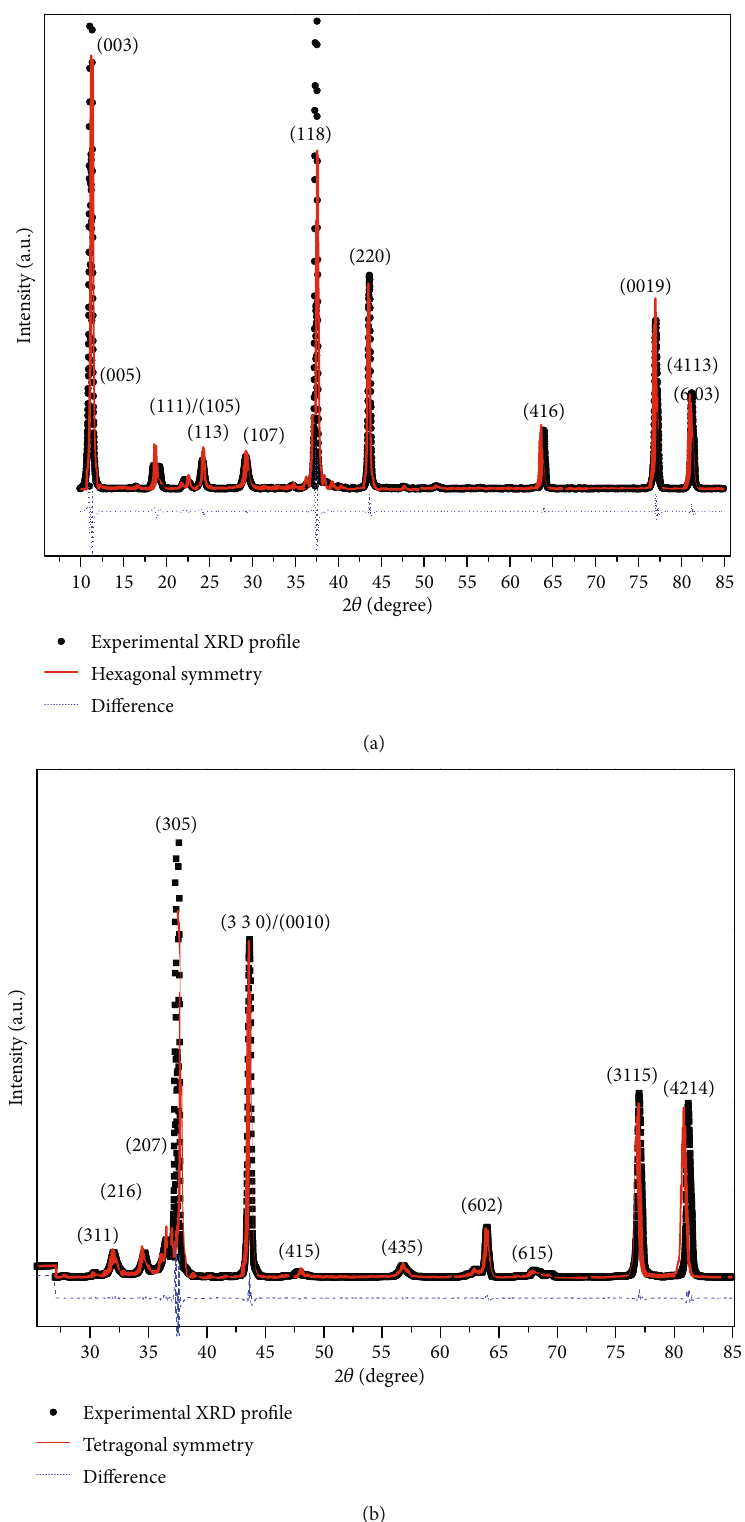
Figure 2: (a) X-ray di ff raction plot of as-prepared layered double hydroxide (LDH) powder (sample LDH75) and structural re fi nement using Rietveld fi tting (P 6/mm m) on the X-ray di ff raction (XRD) pro fi le, along with the di ff erence fi tting curve. (b) Tetragonal (P4) structural fi tting of the X-ray di ff raction plot of the layered double oxide (LDO)